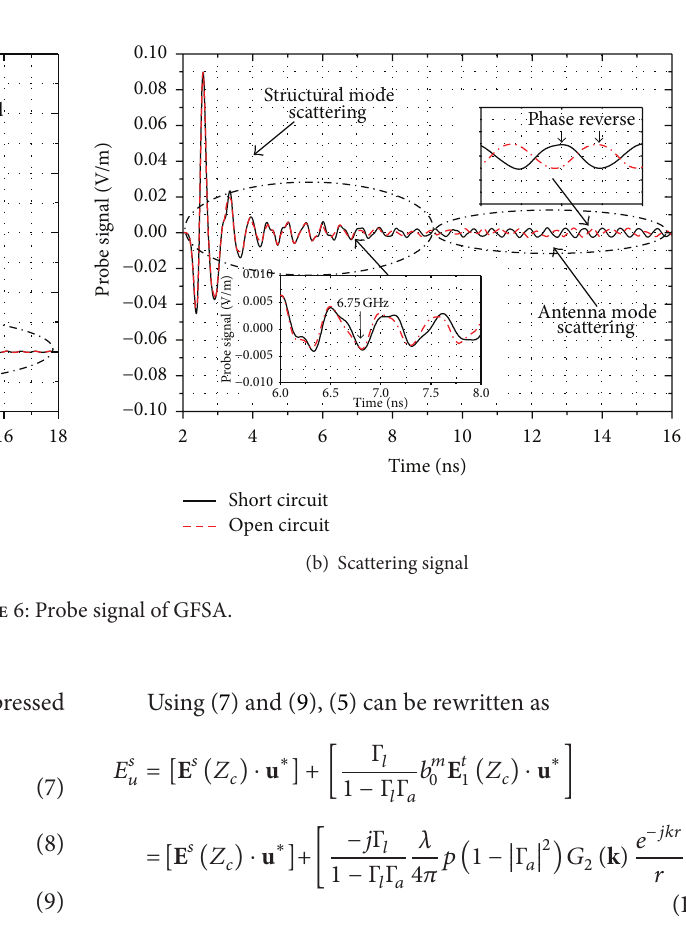
Figure 5: Measured and simulated LHCP radiation patterns.